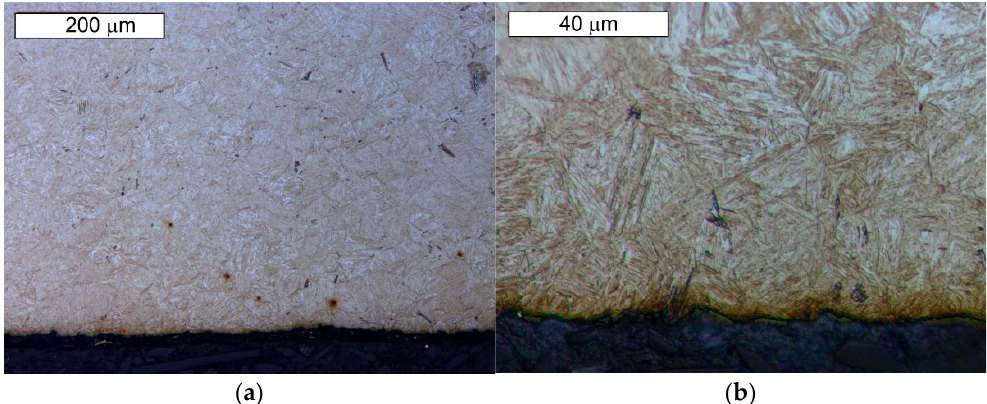
Figure 10. Material microstructure in the wear area on the cross-section of sample 2: ( a ) visible basically uniform surface fatigue; ( b ) magnified fragment of the area from Figure 10a. Light microscopy, etched state.